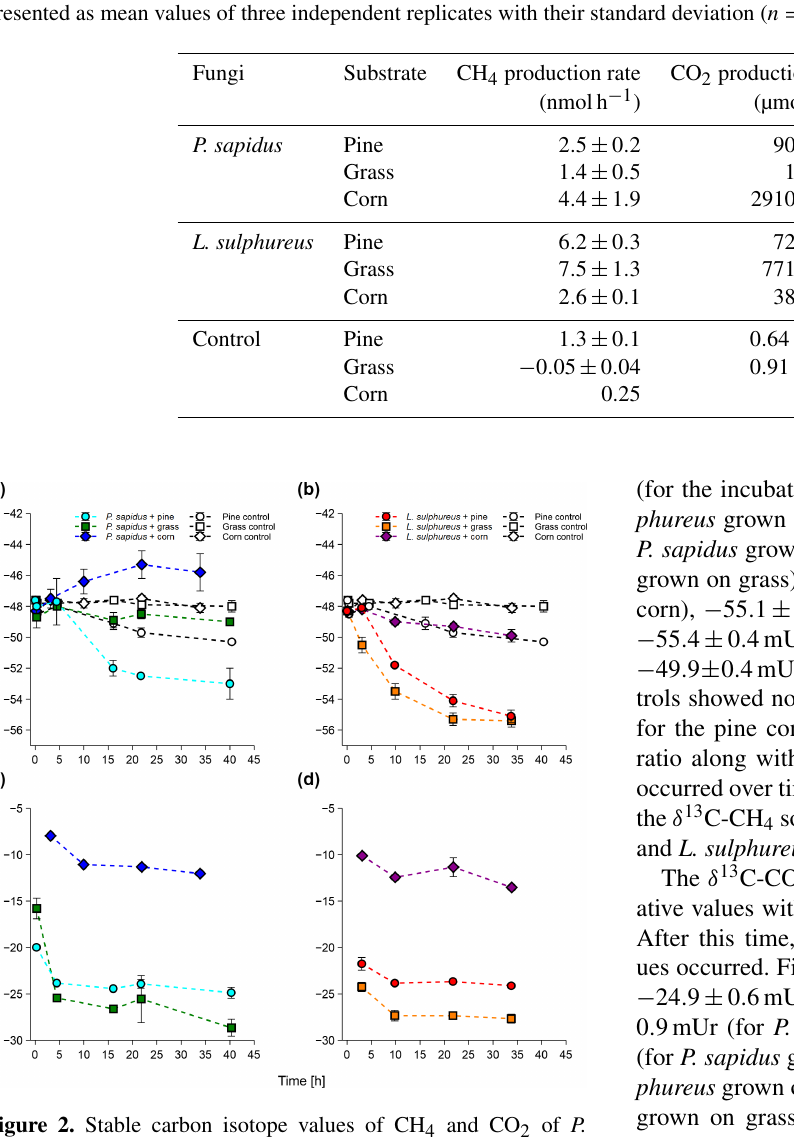
Figure 2. Stable carbon isotope values of CH 4 and CO 2 of P. sapidus (a, c) and L. sulphureus (b, d) grown on pine, grass, and corn. Values are presented as mean values with their standard devi- ation ( n = 3), except for δ 13 CO 2 values of L. sulphureus grown on corn ( n =